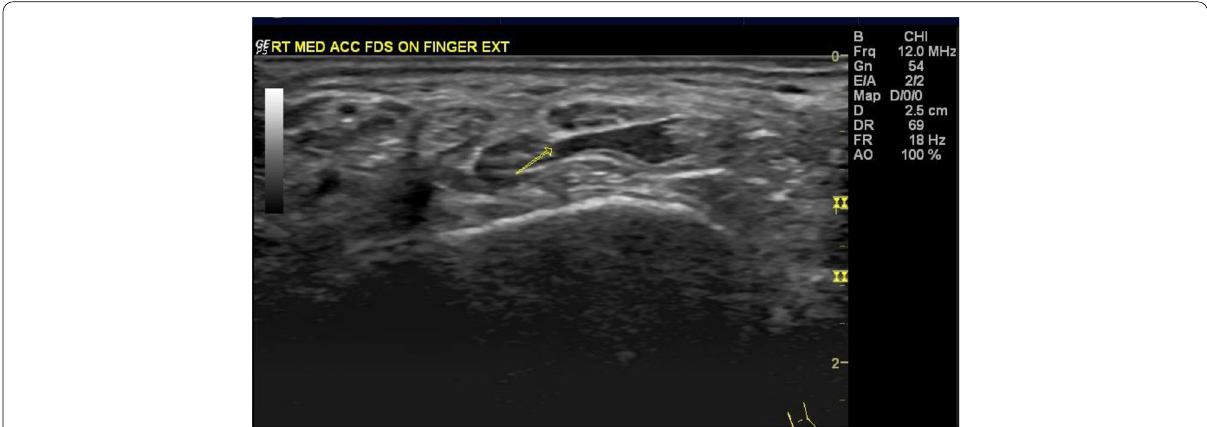
Fig. 7 Transverse section of the median nerve at the carpal tunnel showing intrusion of muscle fiber on the extension which appears hypoechoic (yellow arrow) and disappears on flexion of the fingers and wrist as the muscle contracts